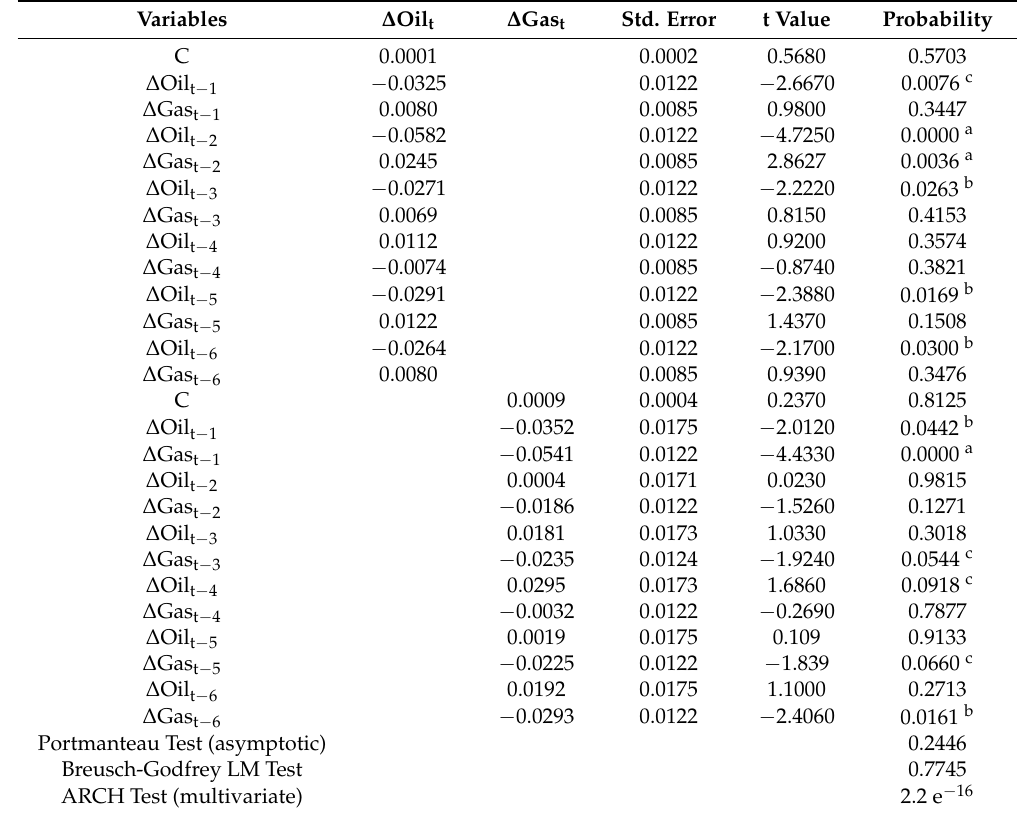
Table 5. Bivariate Vector Autoregression